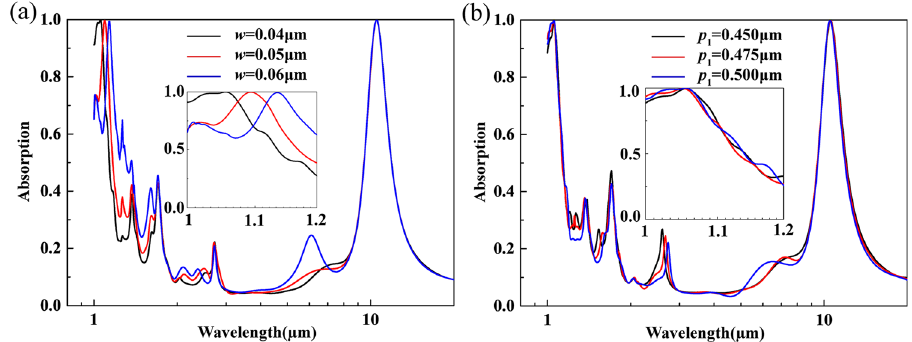
Figure 4. Response of absorption spectrum of the proposed absorber to different parameters of gold ring structure. ( a ) Period and ( b ) Width.